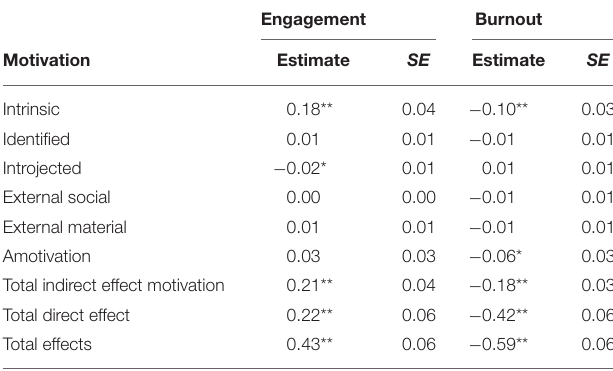
TABLE 2 | Indirect standardized effects after conducting bootstrapping for work engagement and